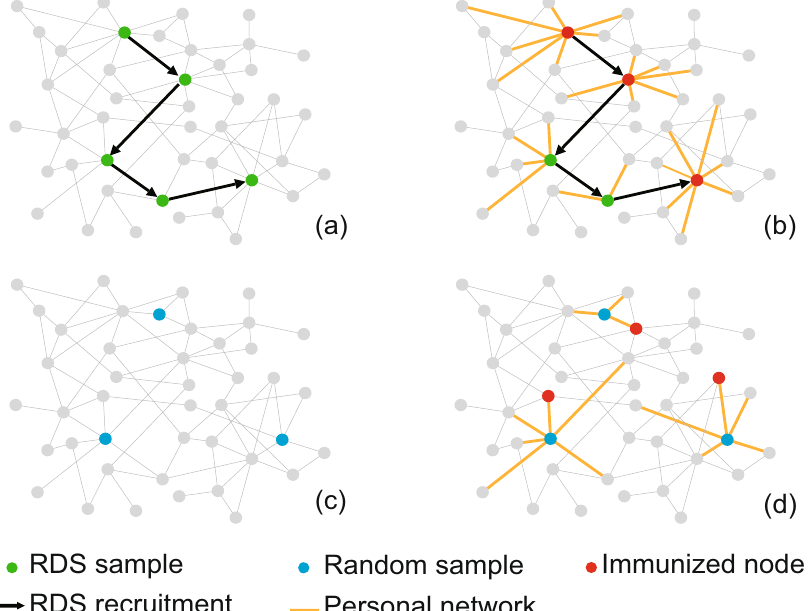
Figure 1. Immunization process utilising the RDS strategy with k cut = 7 and a popular local immunization strategy called acquaintance immunization. In the RDS strategy, ( a ) the immunization process begins with a RDS process and ( b ) the individuals whose degree k ≥ 7 during the RDS chain are immunized. Compared to the RDS strategy, ( c ) the acquaintance strategy needs to randomly select individuals at the beginning and then ( d ) randomly immunizes a neighbour of the selected